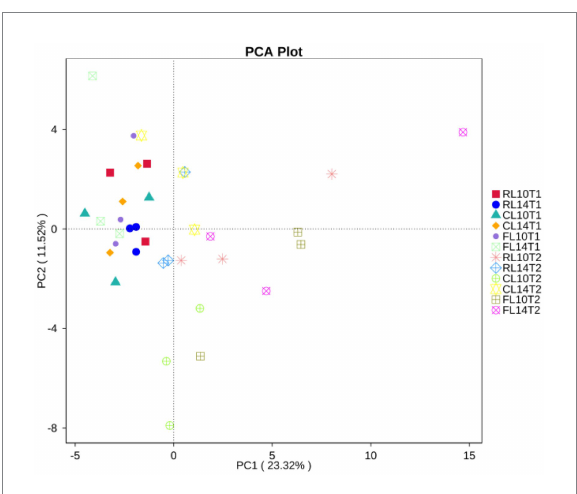
FIGURE 4 Principal component analyses (PCA) of soil functional community of soybean cultivars under crop rotation and continuous